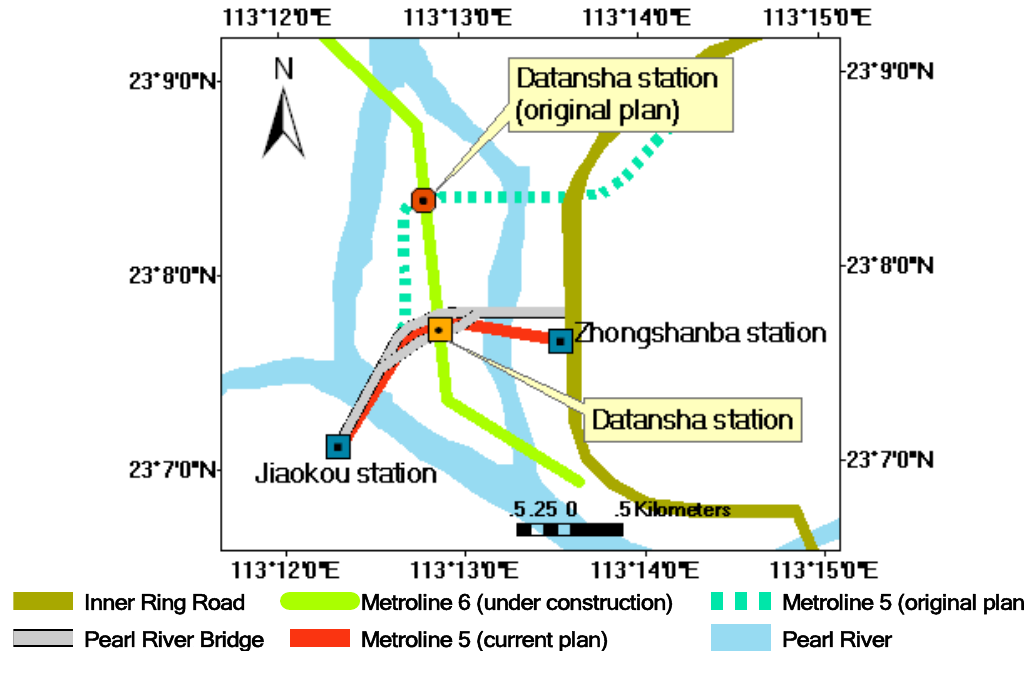
Figure 7. Datansha Island area and underground metro-lines (partially referred to